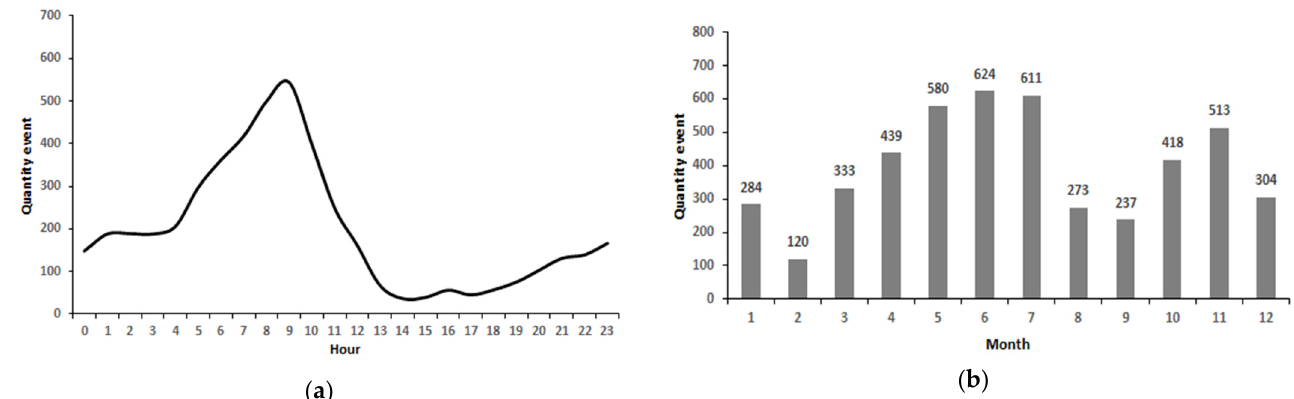
Figure 3. Representation of the hourly ( a ) and monthly ( b ) distribution of 4736 15 min meteorological records where the ceiling was ≤ 1000 ft.